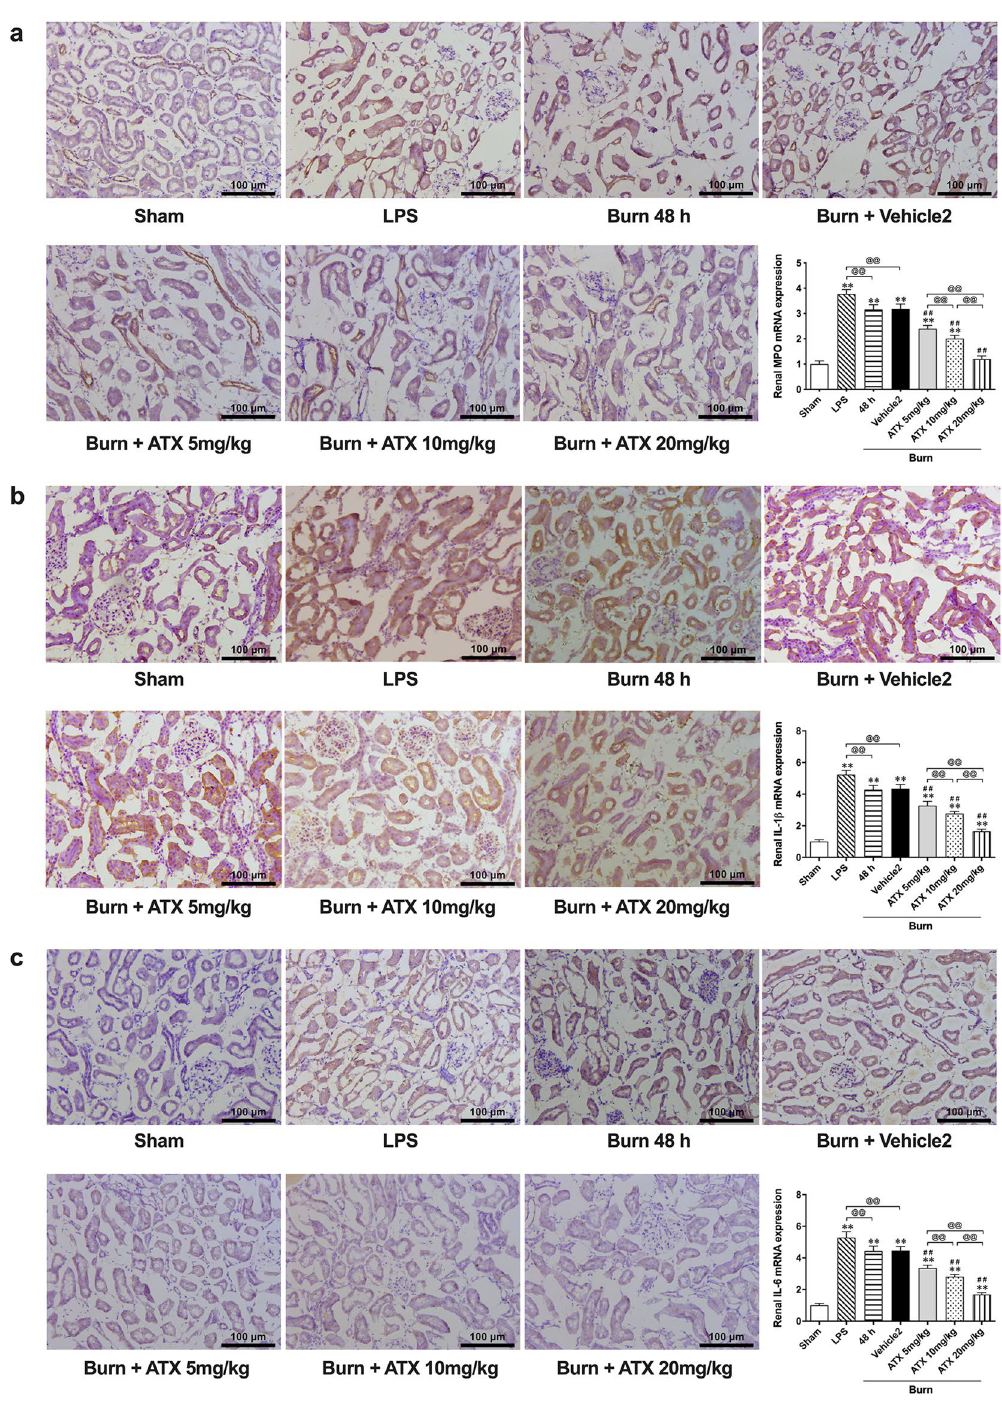
Figure 4. Astaxanthin dose-relatively decreases the burn-induced release of inflammatory mediators. ( a ) Representative immunohistochemical images and tissue mRNA levels of MPO with ATX treatment; ( b ) Representative immunohistochemical images and tissue mRNA levels of IL-1β with ATX treatment; ( c ) Representative immunohistochemical images and tissue mRNA levels of IL-6 with ATX treatment. n = 6 for each group. The results are expressed as the mean ± SD. * p < 0.05, ** p < 0.01, v.s. sham; # p < 0.05, ## p < 0.01, v.s. vehicle2; @ p < 0.05, @@ p < 0.01, ns p >